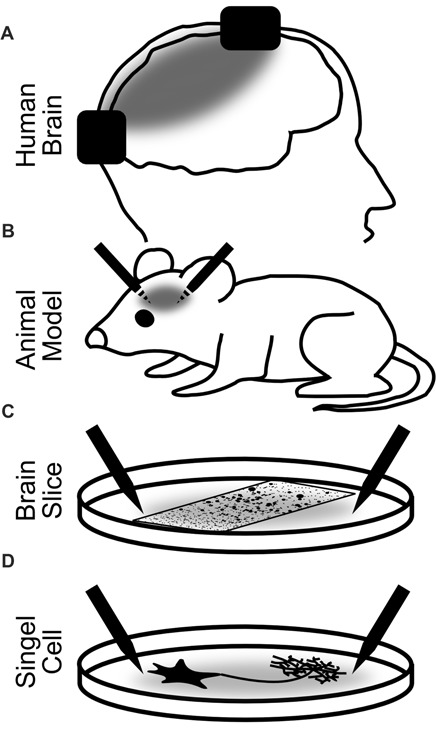
Explanatory levels of brain stimulation with alternating currents. Black rectangles (A) and needles (B–D) depict the stimulation electrodes. Gray areas illustrate the electric fields between the electrodes. (A) Stimulation of the human brain. Most restricted in the insights into the neural dynamics and stimulation parameters but most relevant for the observation of cognitive effects. Most often, non-invasive but also invasive recordings and stimulation have been used. (B) Invasive stimulation of animals allows for more precise and controlled stimulation and accurate recordings. Only limited observation of cognitive effects of stimulation is possible. (C) Stimulation of brain slices or cell assemblies. Highly controlled stimulation and recording are possible. Network effects of stimulation can be observed but no behavior. (D) Stimulation of a single neuron. Observations of the effect of alternating currents on different parts of the neuron down to the single iron channel or synapse are possible.